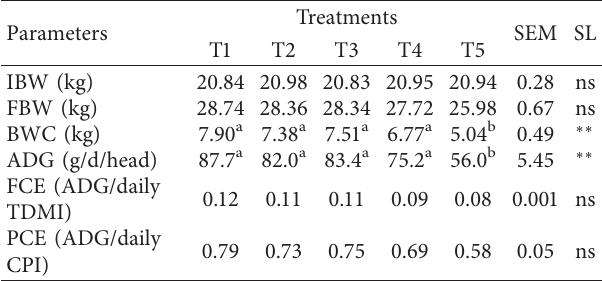
Table 5: Growth performances of Bonga lambs fed on Rhodes grass hay basal diet and supplemented with dried mulberry and Vernonia mixed leaves’ meal substituting noug seed cake of the concentrate mix at different levels.